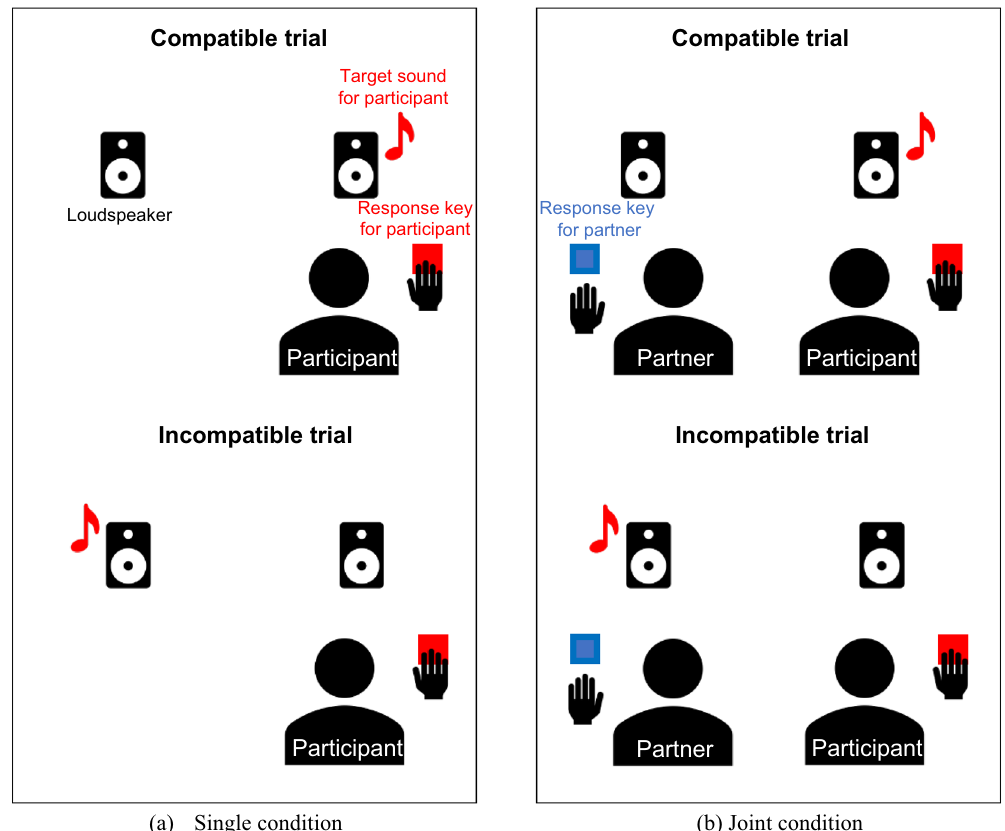
Figure 1. ( a ) Simple auditory go/no-go task (single condition) and ( b ) auditory social Simon effect (SSE) task with a partner (Joint